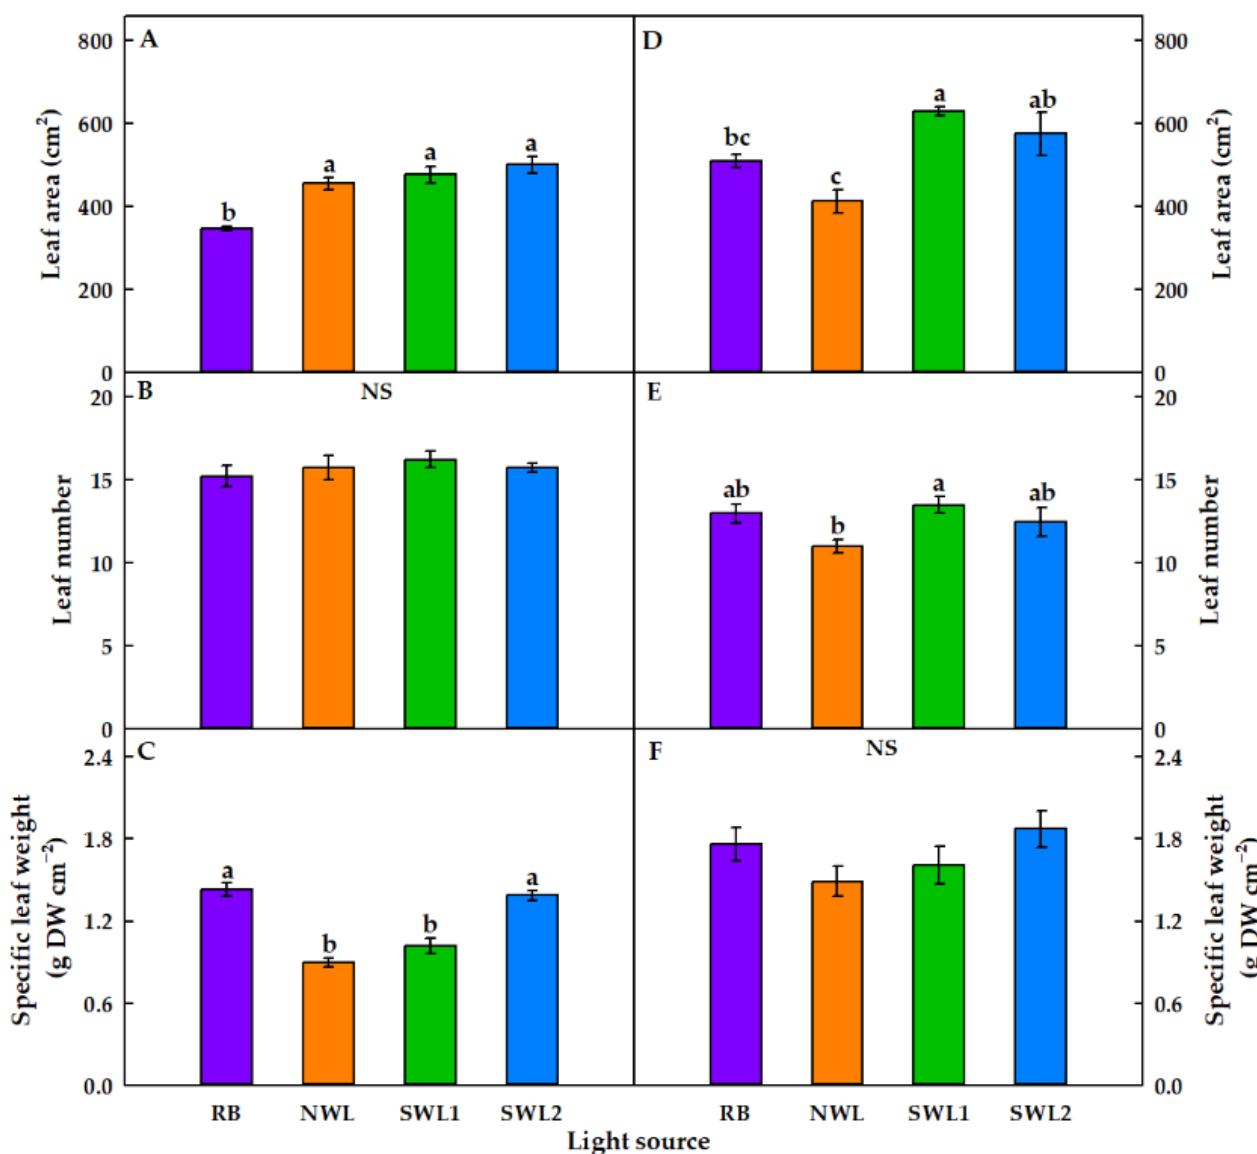
Figure 8. Leaf area, leaf number, and specific leaf weight of butterhead lettuce ( A – C ) and romaine lettuce ( D – F ) plants grown under various light sources with the same PPFD after 4 weeks of transplanting. Different letters indicate significant difference at p < 0.05 ( n = 4).